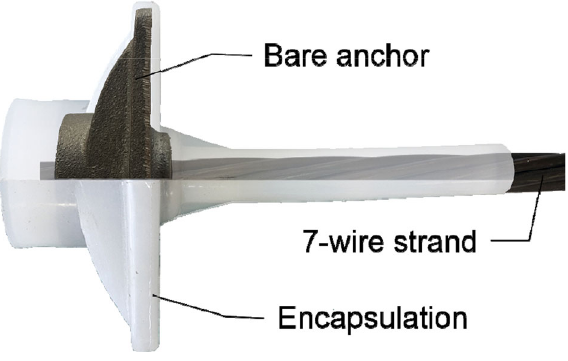
Fig. 1 Prototype of developed encapsulated